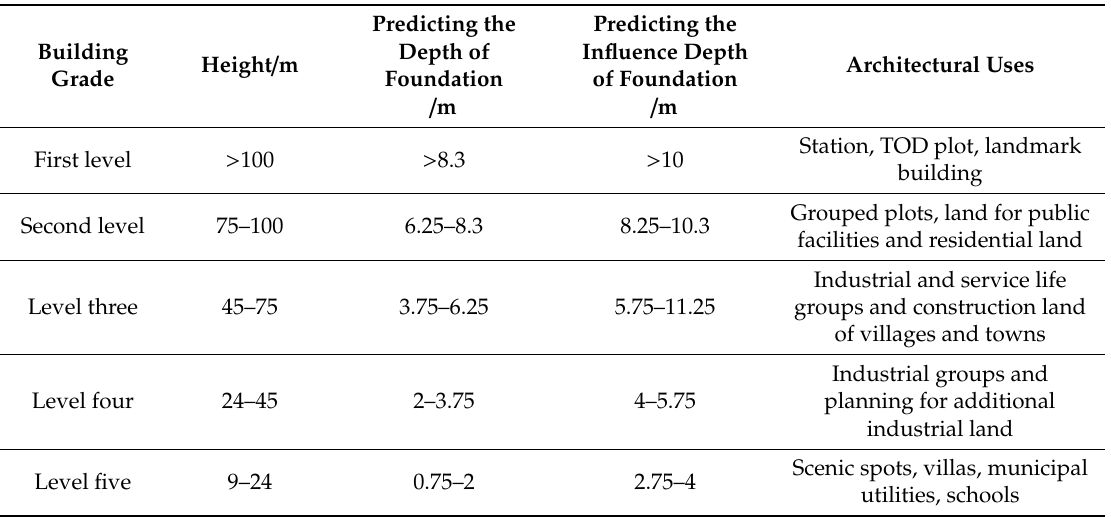
Table 11. Height division and influence range of buildings with di ff erent grade natural